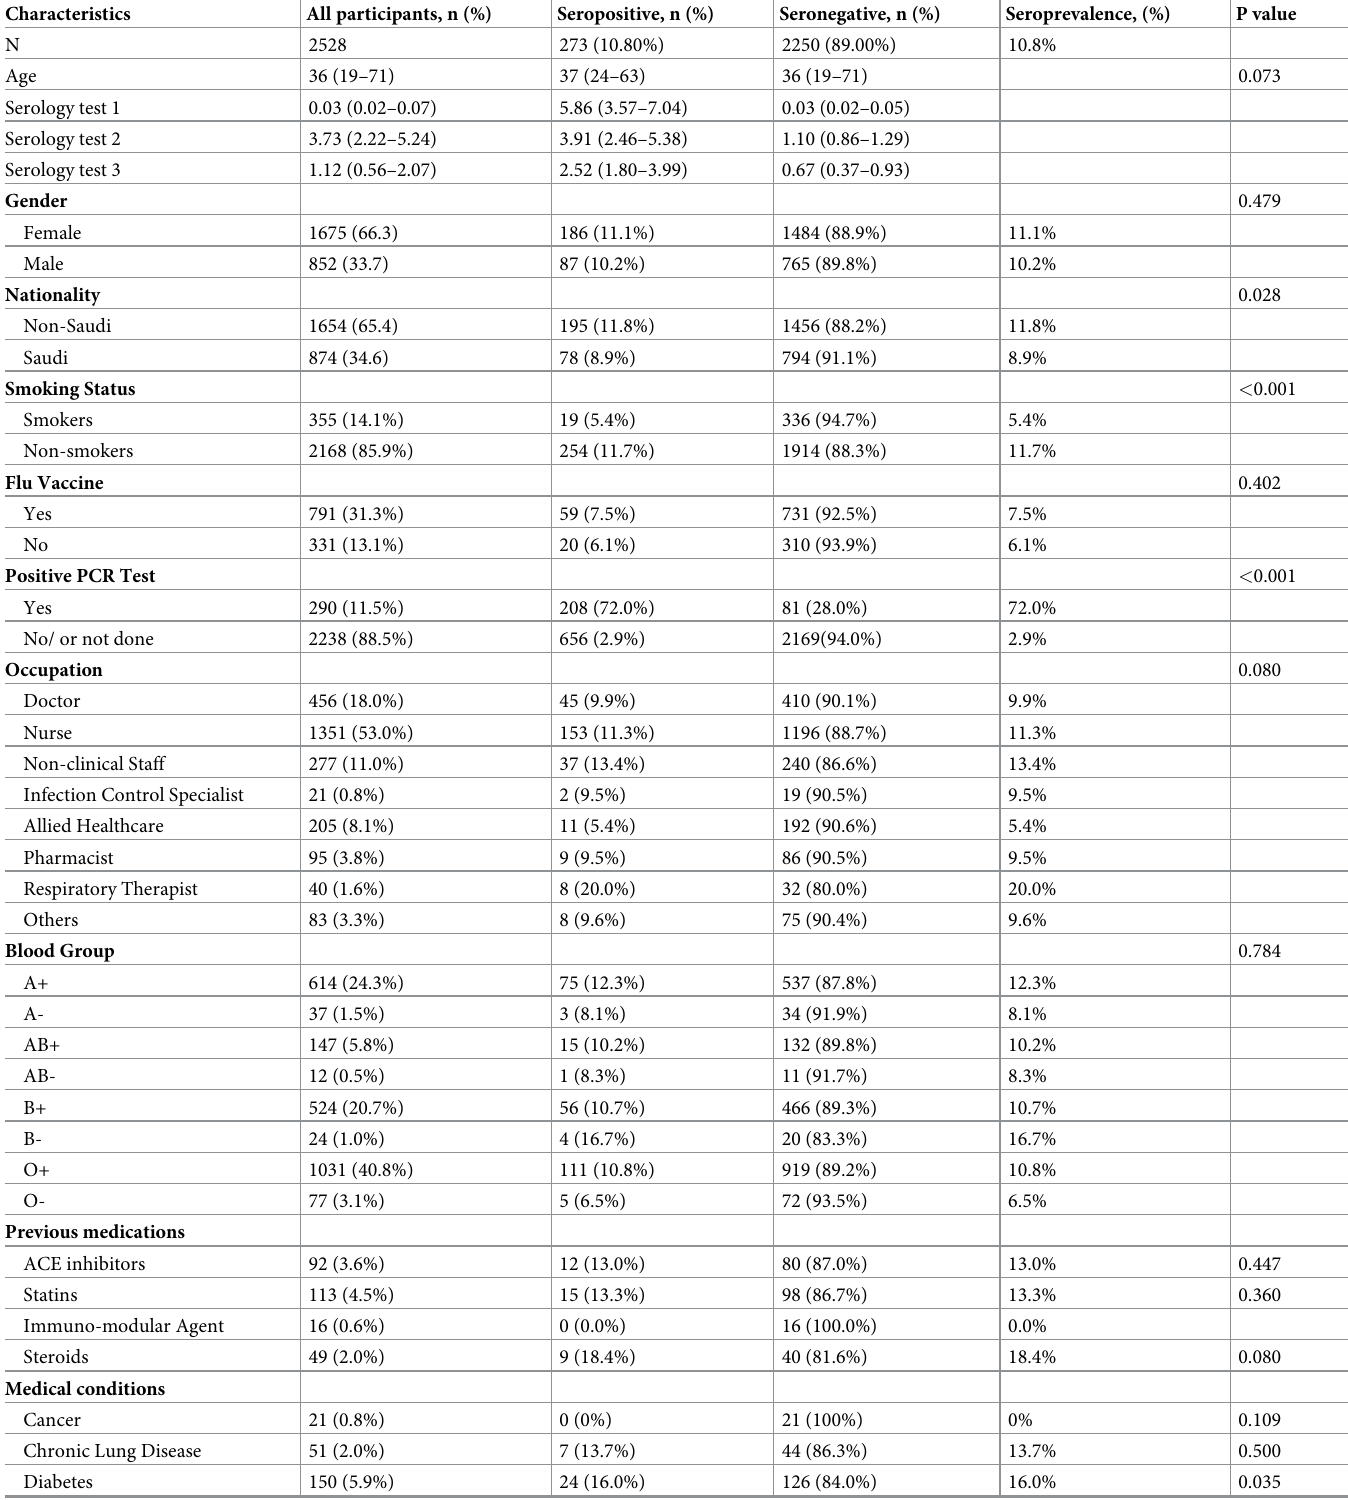
Table 1. Demographics and clinical characteristics of study